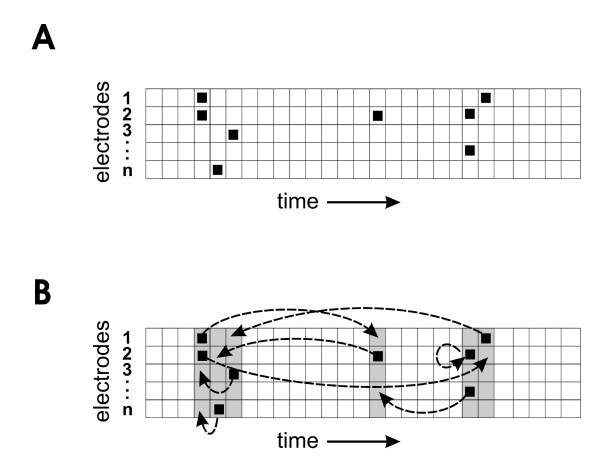
Shuffling scheme. A, Representation of unshuffled network activity in raster format. Black squares indicate LFP signals over threshold; each row is activity from an electrode; each column is one time bin. B, Shuffling of activity. Gray columns indicate time bins where at least one electrode was active in the unshuffled data. Dashed arrows indicate example shuffles allowed by this procedure. Activity from a given electrode can only be shuffled to another gray time bin in the same row.